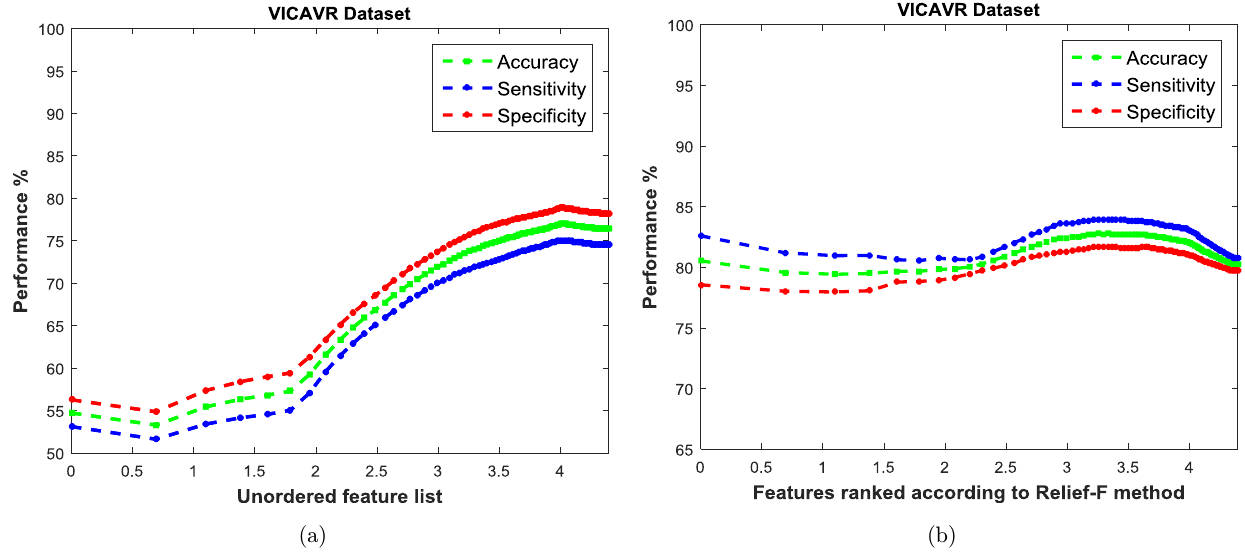
Fig. 17. Comparison of classi¯cation accuracy achieved for raw feature subsets (unordered) and ordered feature list using Relief-F method on k -NN classi¯er for VICAVR dataset. (a) Classi¯cation performance of feature subsets from unordered feature list and (b) Performance attained using feature subsets from ranked lists acquired through Relief-F